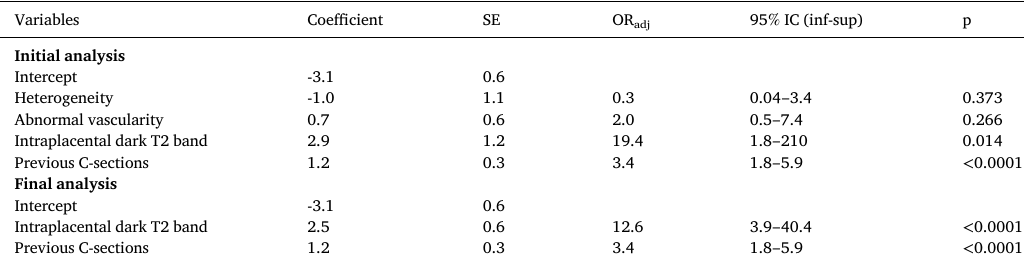
Table 5 Multiple binary logistic regression models of independently most signi fi cant variables. Variables